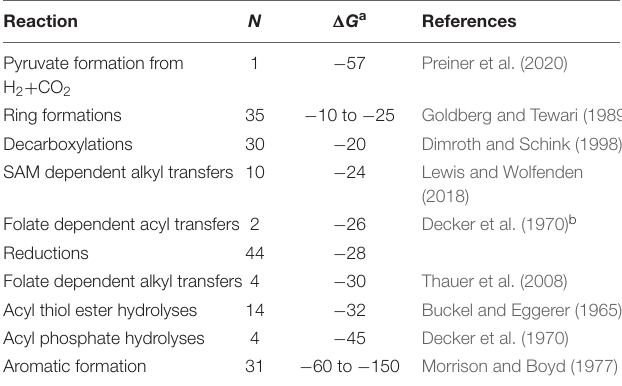
TABLE 2 | Energy release in the